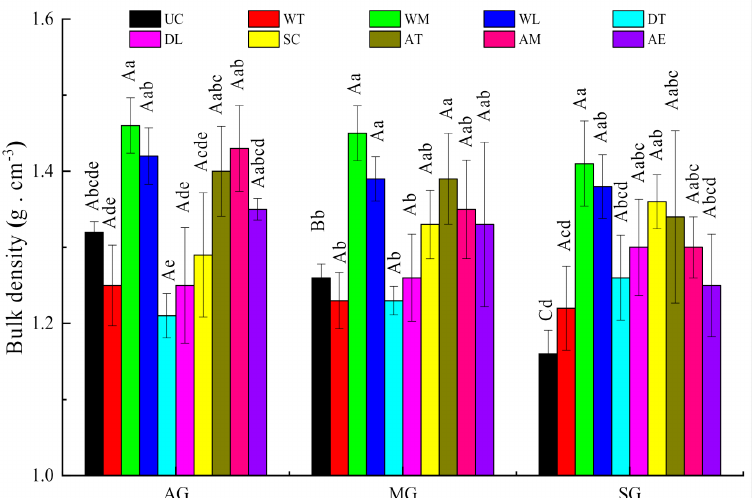
Figure 3. Bulk density in the different spatial position in different stages of Benggang restoration. AG: active stage of Benggang; MG: semi-stable stage of Benggang; SG: stable stage of Benggang. UC: upper catchment; WT, WM, WL: the top, middle and lower of collapsing wall; DT, DL: the top and lower of colluvial deposit; SC: scour channel; AT, AM, AE: the top, middle and edge of alluvial fan. Different capital letters mean significant differences between different development stages of Benggang in the same position, different small letters mean significant differences between different positions of Benggang at the same development stage at 0.05 level. The same as